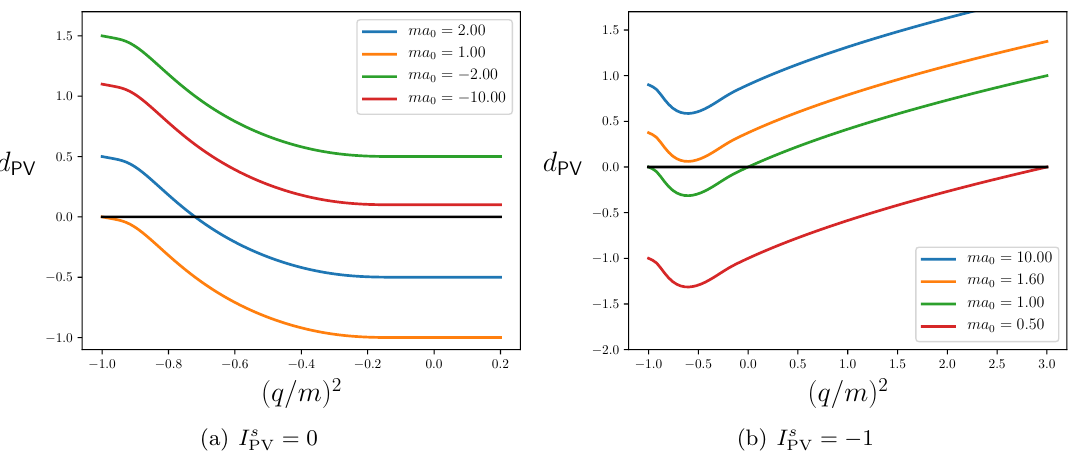
Figure 2 . Plots of the denominator of e K s , d PV ( q 2 ), vs. q 2 =m 2 for a range of choices of am with 2 I s = 0 (left) and I s = (cid:0) 1 (right). There is a pole in e K s whenever d PV ( q 2 ) vanishes. See text 2 PV PV for further